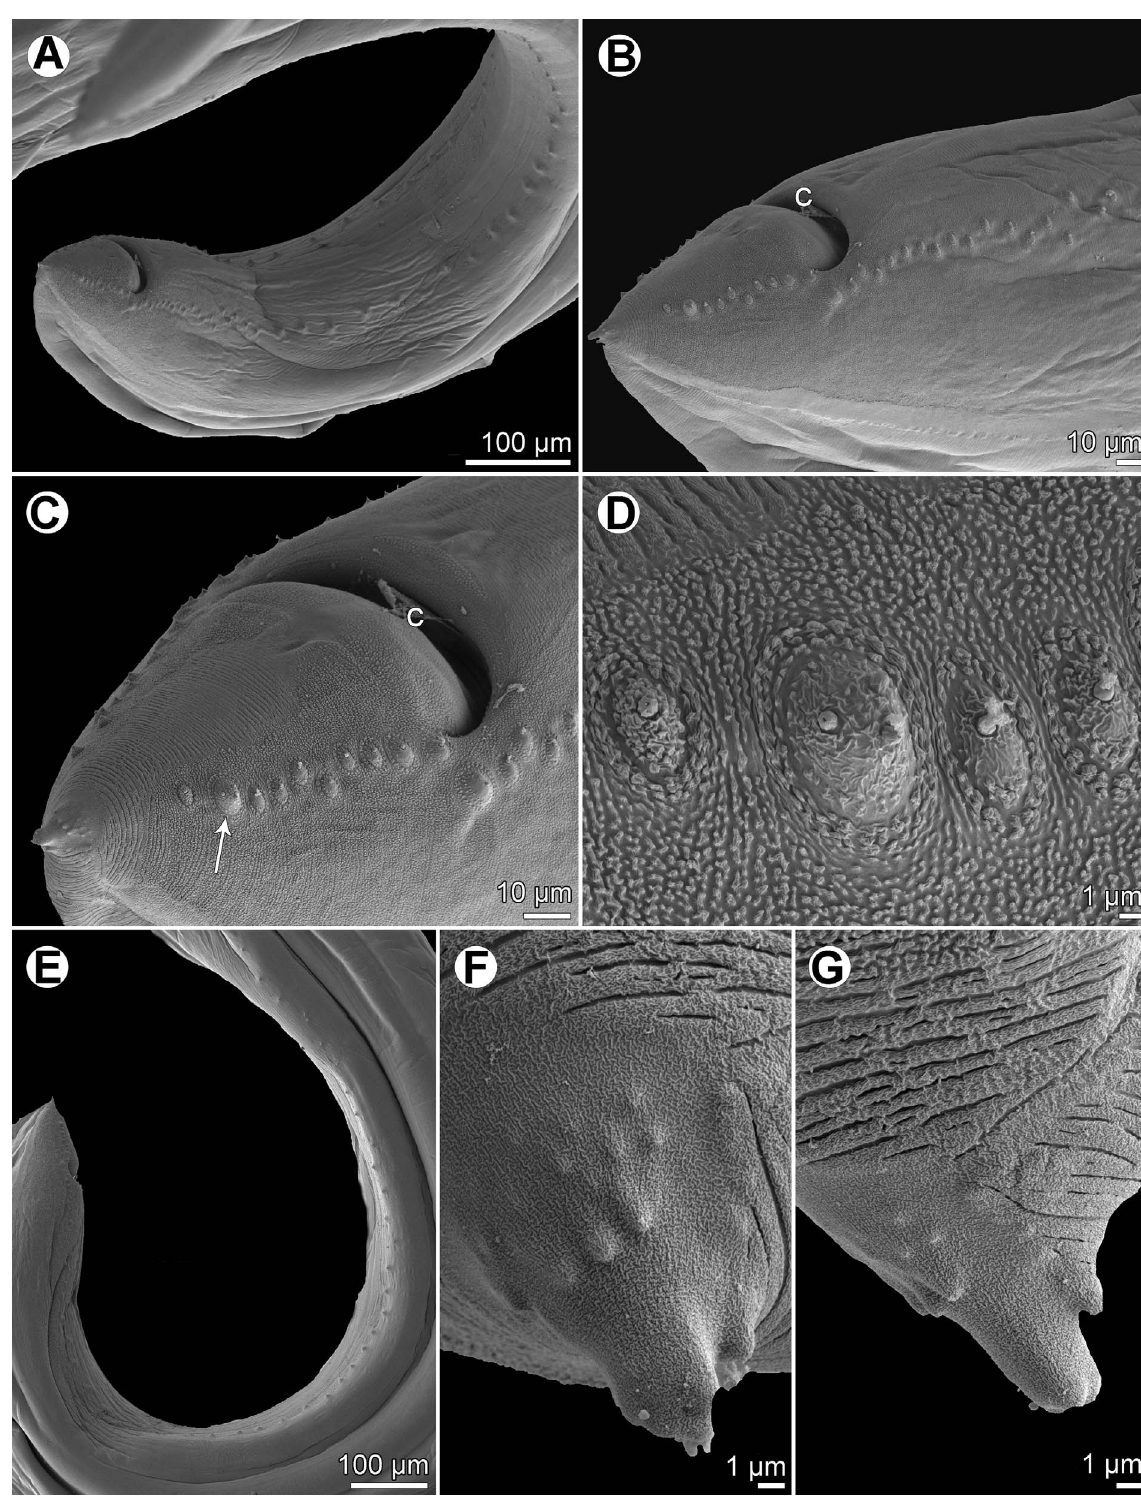
Figure 11. Raphidascaris ( Ichthyascaris ) euani n. sp., scanning electron micrographs of male. (A) Posterior end of body, subventral view; (B) posterior end (enlarged), ventrolateral view; (C) tail, ventrolateral view (arrow indicates postanal triple papilla); (D) postanal papillae of four posteriormost pairs (note distinct triple papilla); (E) posterior end of body (another specimen), lateral view; (F and G) tail tips of two different specimens. (c) Cloacal